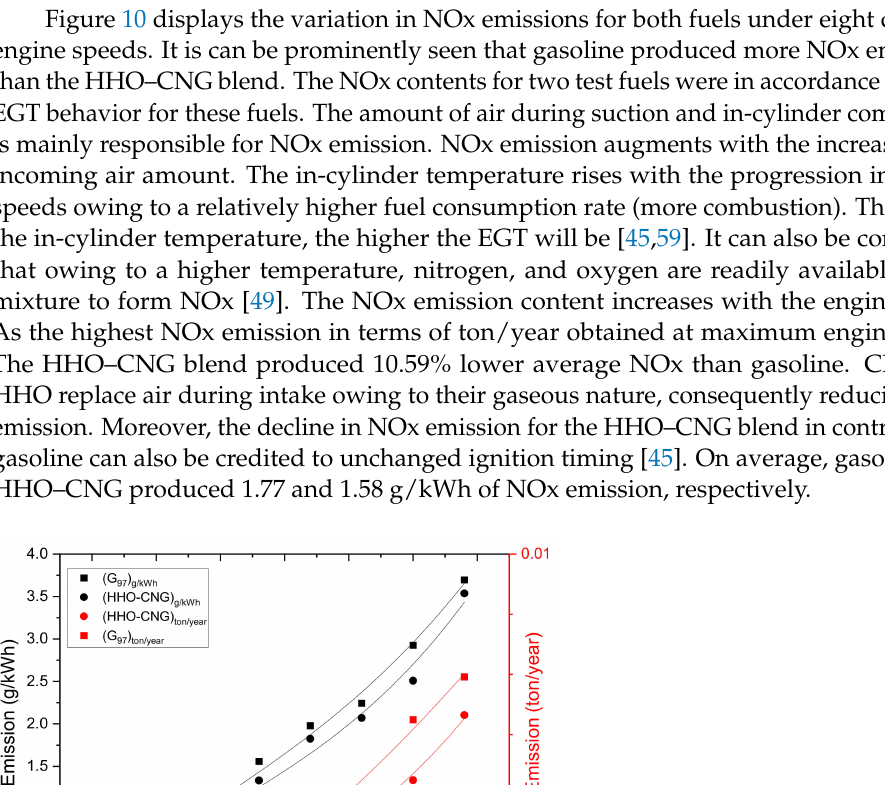
Figure 9. HC emission variation with respect to engine speed in terms of parts per million and ton/year.